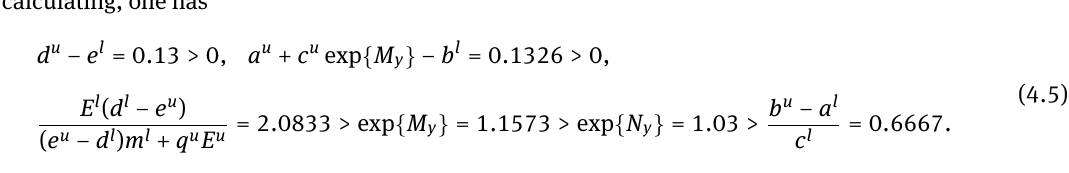
Figure 2: Dynamic behaviors of the solutions ( x * (2, 2.5) and (3, 3.5) ,